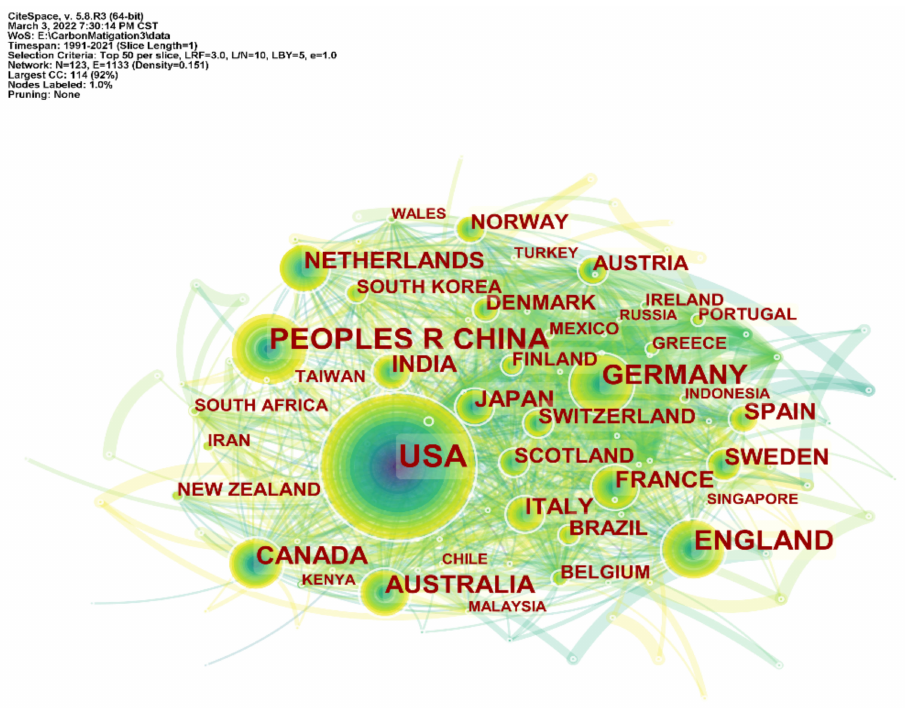
Figure 2. Map of National/Regional Cooperation Networks in the Field of Carbon Mitigation